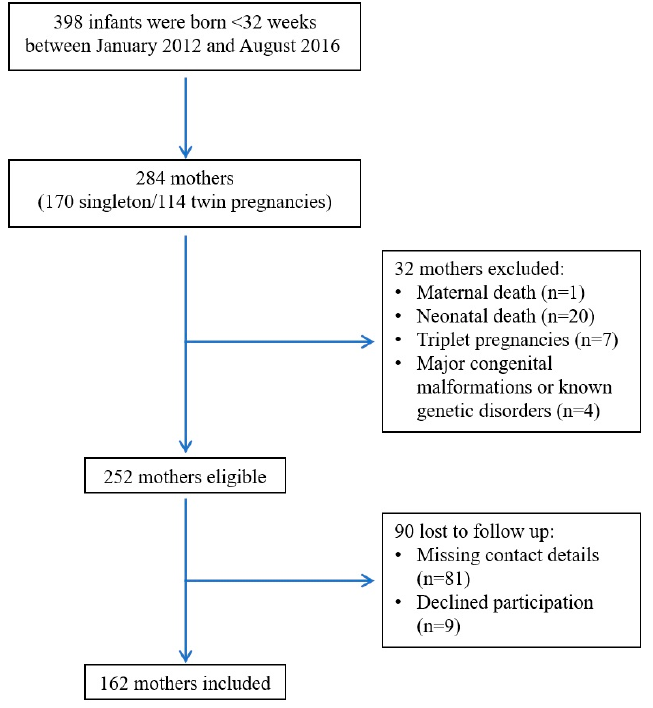
Figure 1. Flow chart of study cohort. Table 1. Comparison between study group and those lost to follow-up.